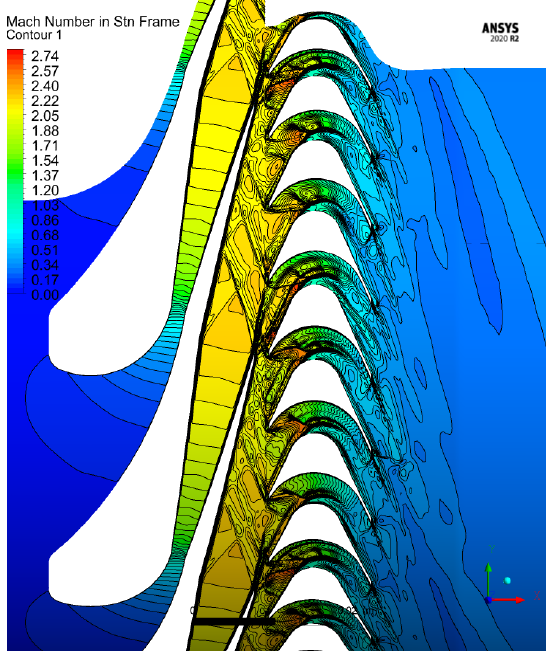
Fig. 5. Midspan contours of Mach number in stationary